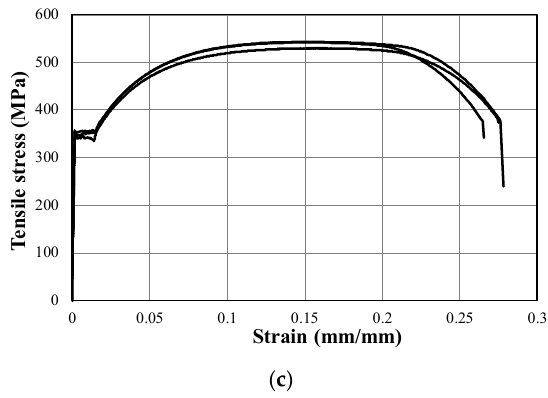
Figure 3. Tensile test result ( a ) SM490TMC-30T (30 mm thk.); ( b ) SM490TMC-20T (20 mm thk.); ( c ) SM490A-20T (20 mm thk.).